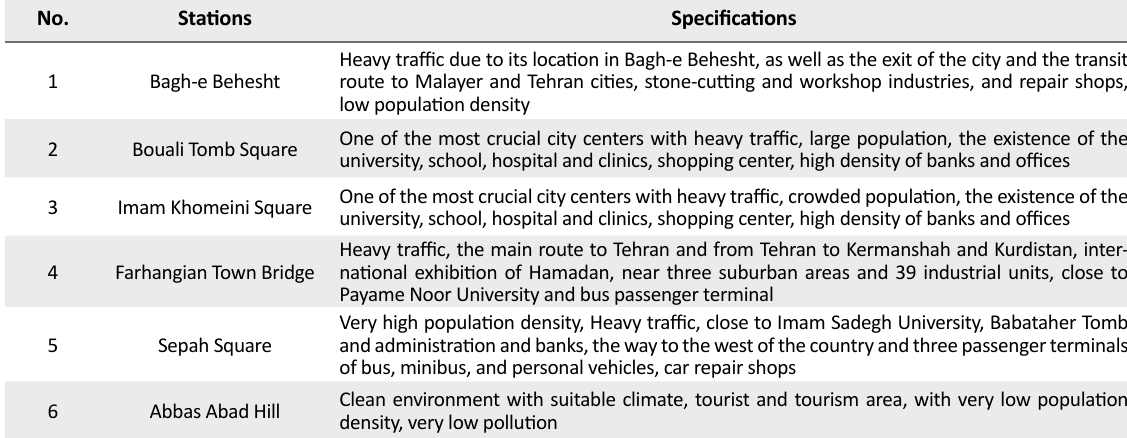
Table 1. Specifications of sampling stations in Hamadan SpecificationsStations